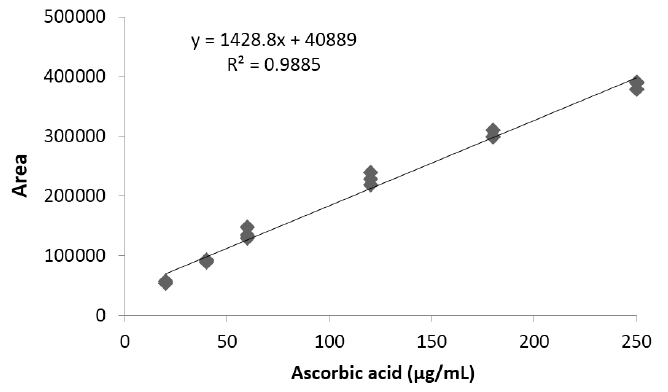
Figure 1. Representative standard curve obtained for vitamin C.